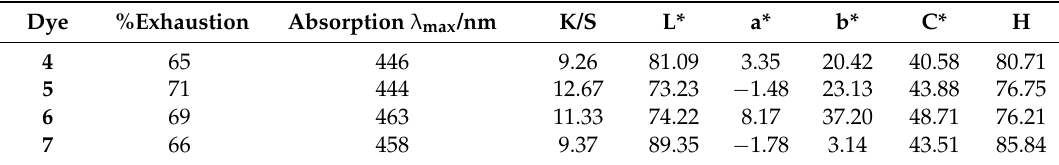
Table 2. Optical measurements of the synthetic dyes on polyester fabrics.